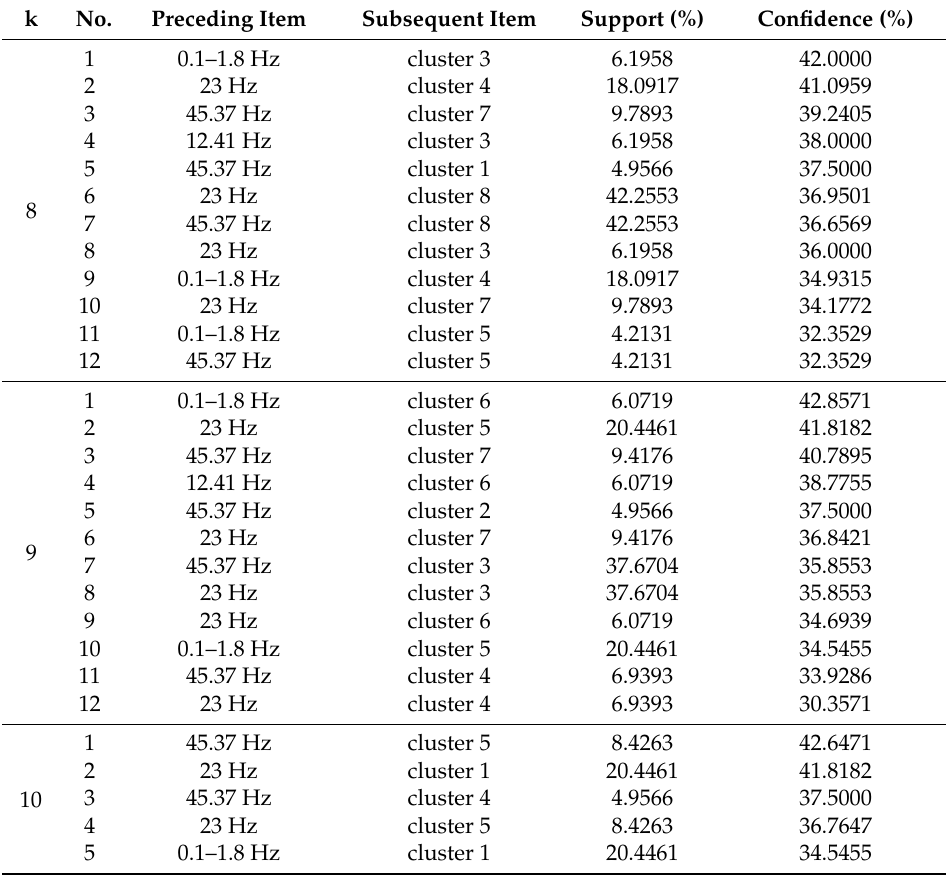
Table 5. Association rules (the same data segment